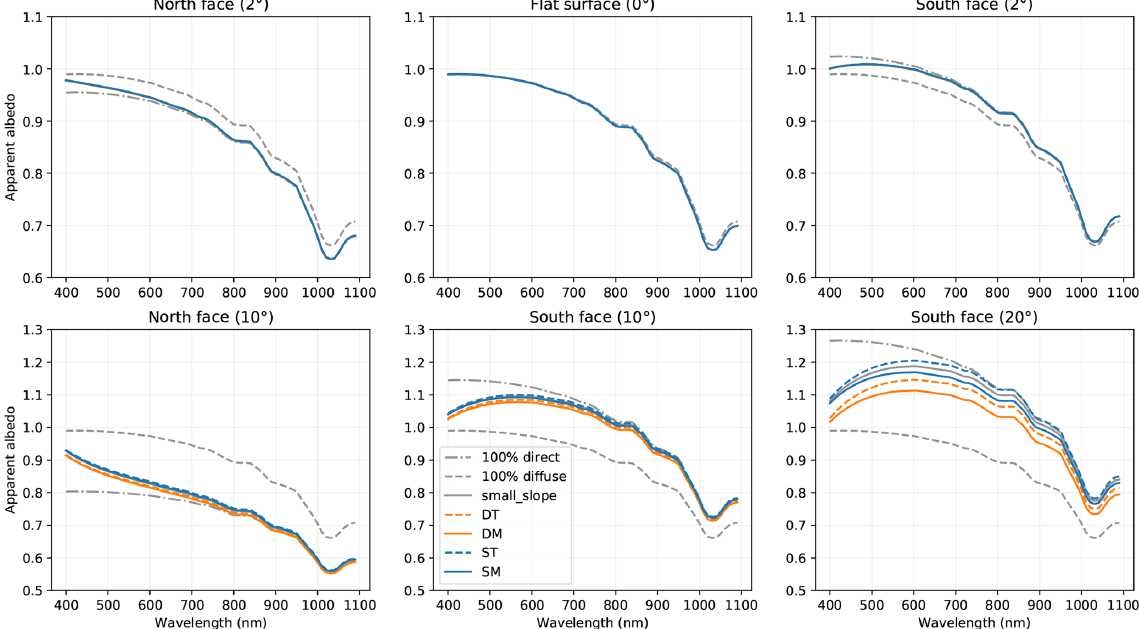
Figure 4. Spectra of apparent albedo for various slopes under blue-sky conditions (the diffuse irradiance decreases as a power of 4 of the wavelength). The grey curves are calculated with the small-slope